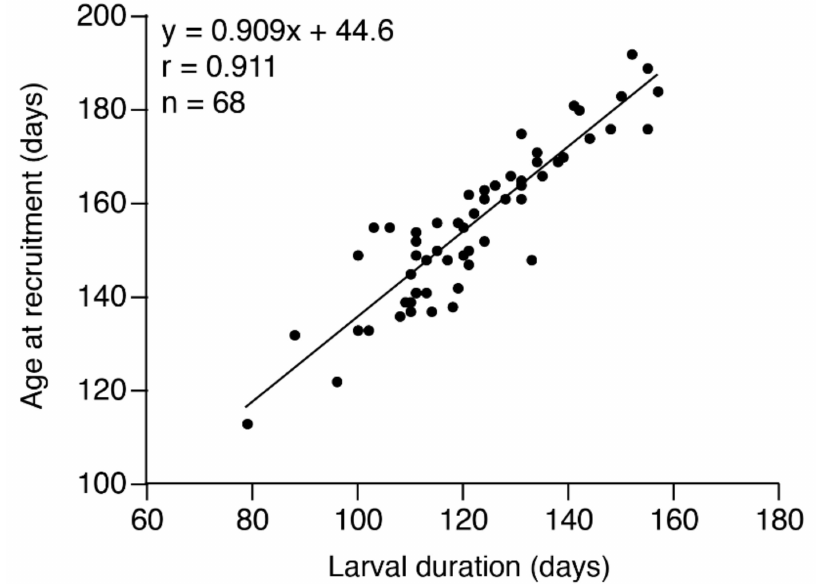
Figure 4. Relationship between larval duration (days) and age at recruitment (days) of Anguilla mar- morata glass eel recruited to southern